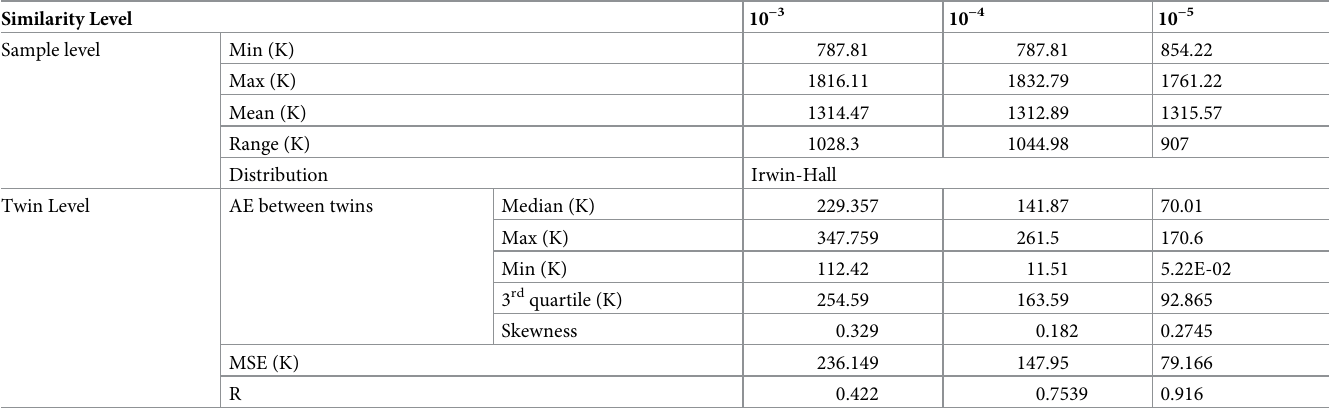
Table 5. Statistics of test sets for different similarity levels. Similarity Level